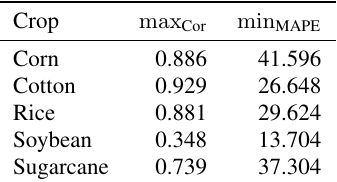
Table 5. Best performance of the model for each crop and metric. max Cor represents the maximum correlation found over all executions for a given crop, while min MAPE represents the minimum MAPE found over all executions for a given crop. Maximum and minimum were computed over a set of thirty independent